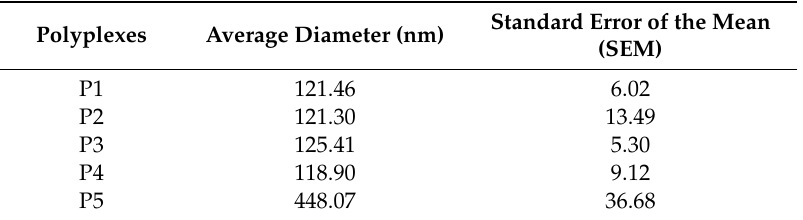
Table 2. Polyplexes synthesised, average size (nm) and